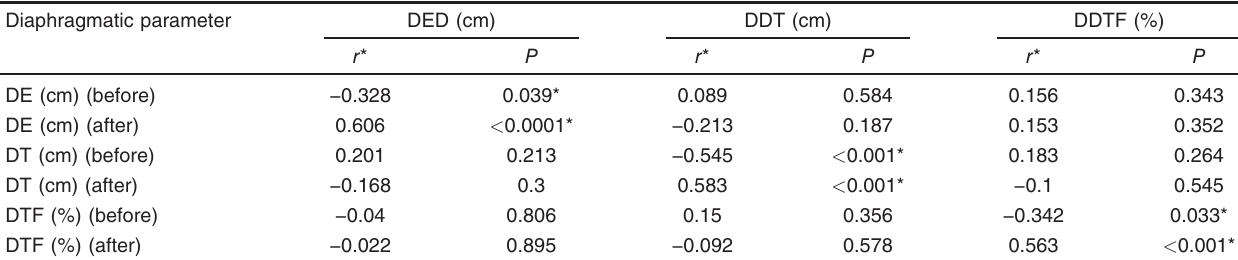
Table 3 Correlation between the ultrasound diaphragmatic parameters before and after weaning and the difference in between Diaphragmatic parameter DED (cm)